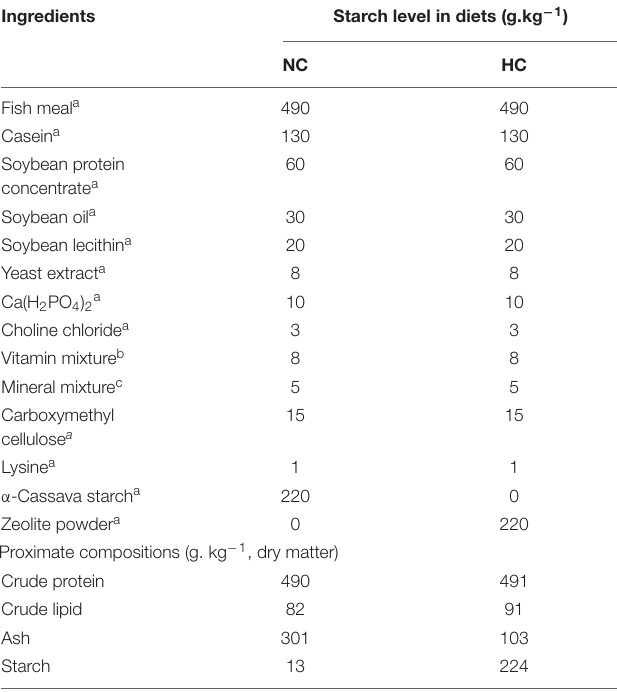
TABLE 1 | Formulation and proximate chemical composition of the trial diets.